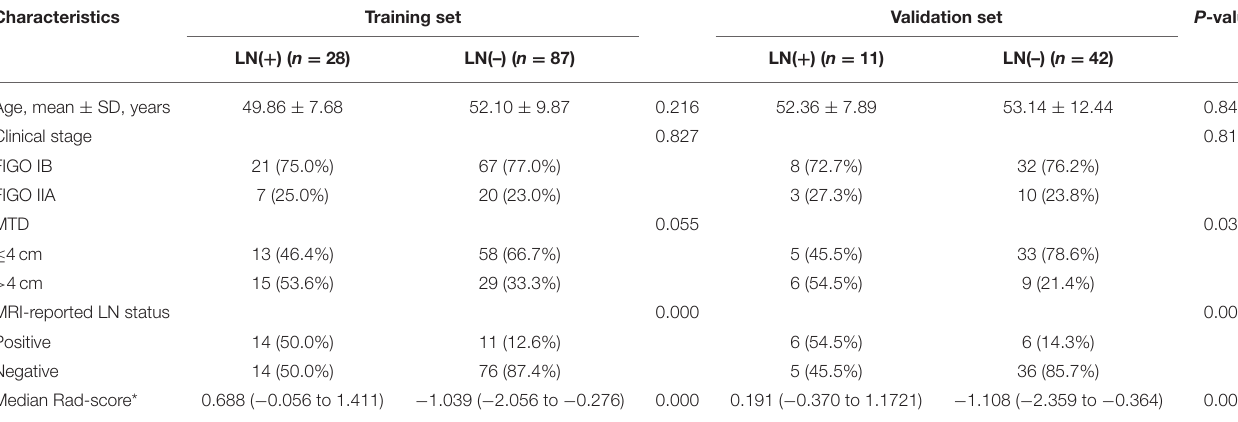
TABLE 1 | Demographic and clinical characteristics of patients with LARC in the training and validation sets.